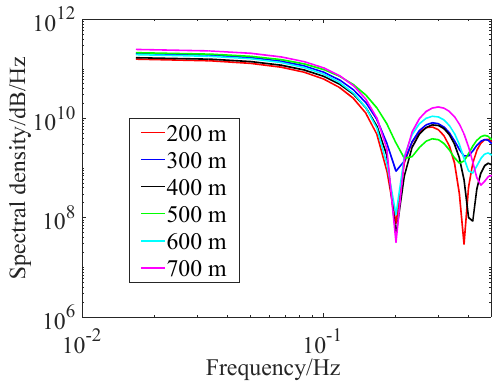
Figure 12. The power spectral density analysis.